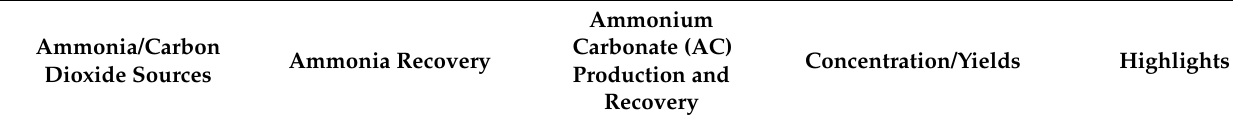
Table 1. Ammonium carbonate (AC) production from more sustainable